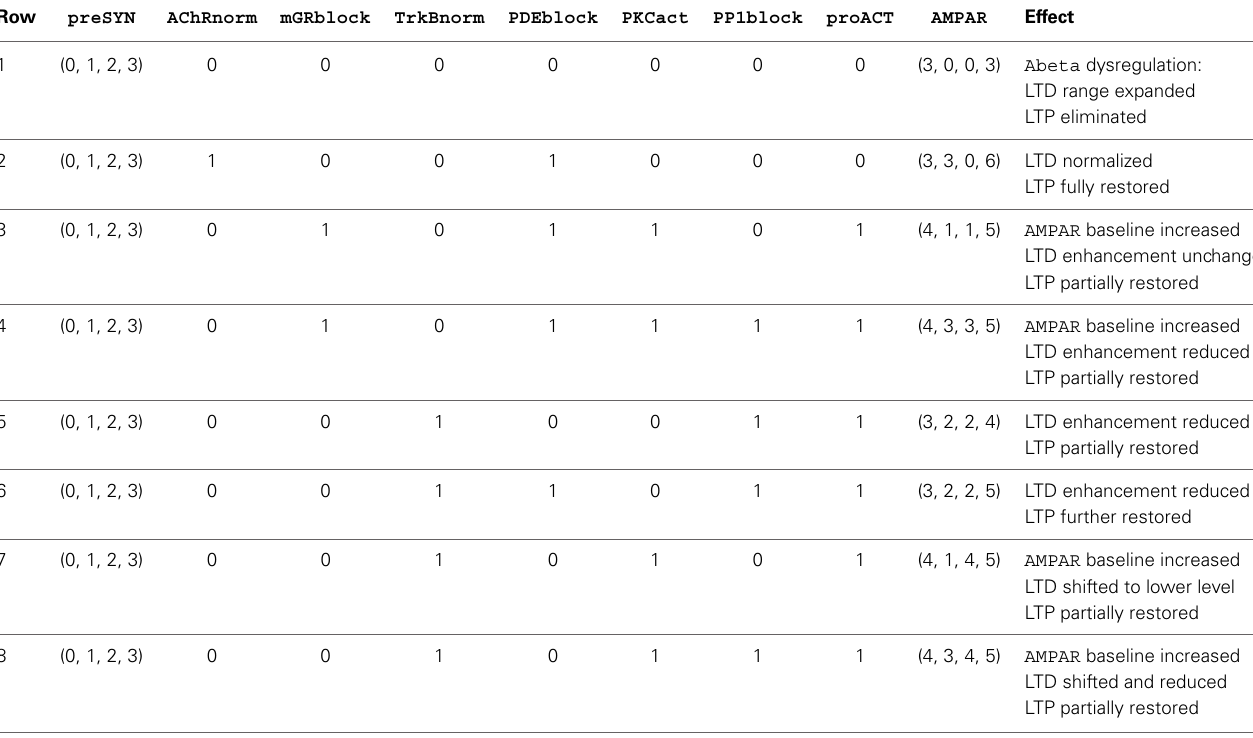
Table 6 | Effects on synaptic plasticity of compounds that modify receptors or